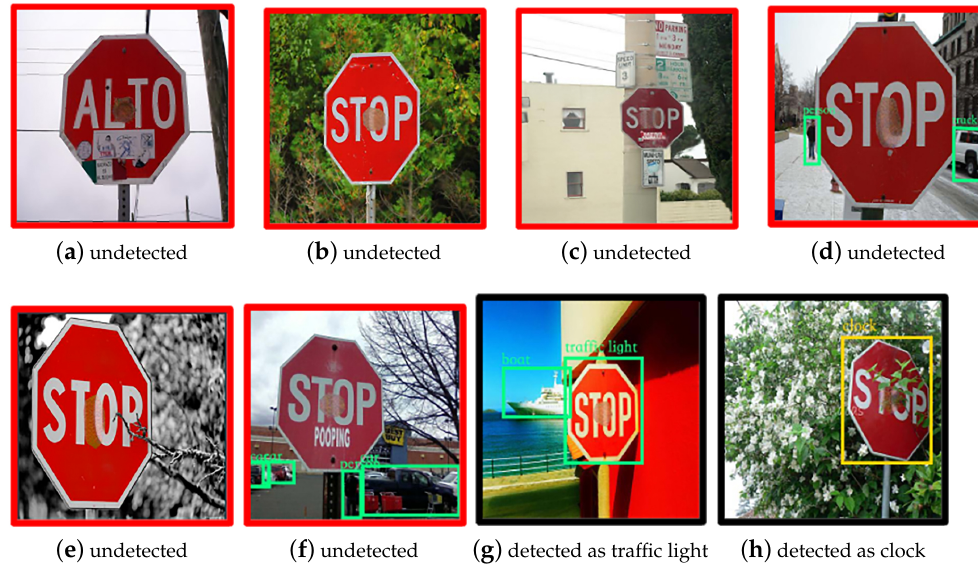
Figure 5. Some examples of adversarial camouflages in the coco dataset generated in the digital domain. Figures with red outlines are examples of successful attacks (i.e., ( a – f ) are undetected by